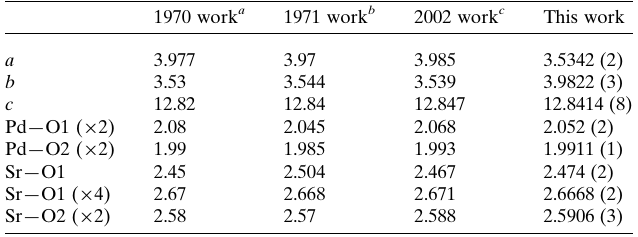
Table 1 Comparison of lattice parameters and bond lengths (A˚ ) in Sr 2 PdO 3 determined in different studies.